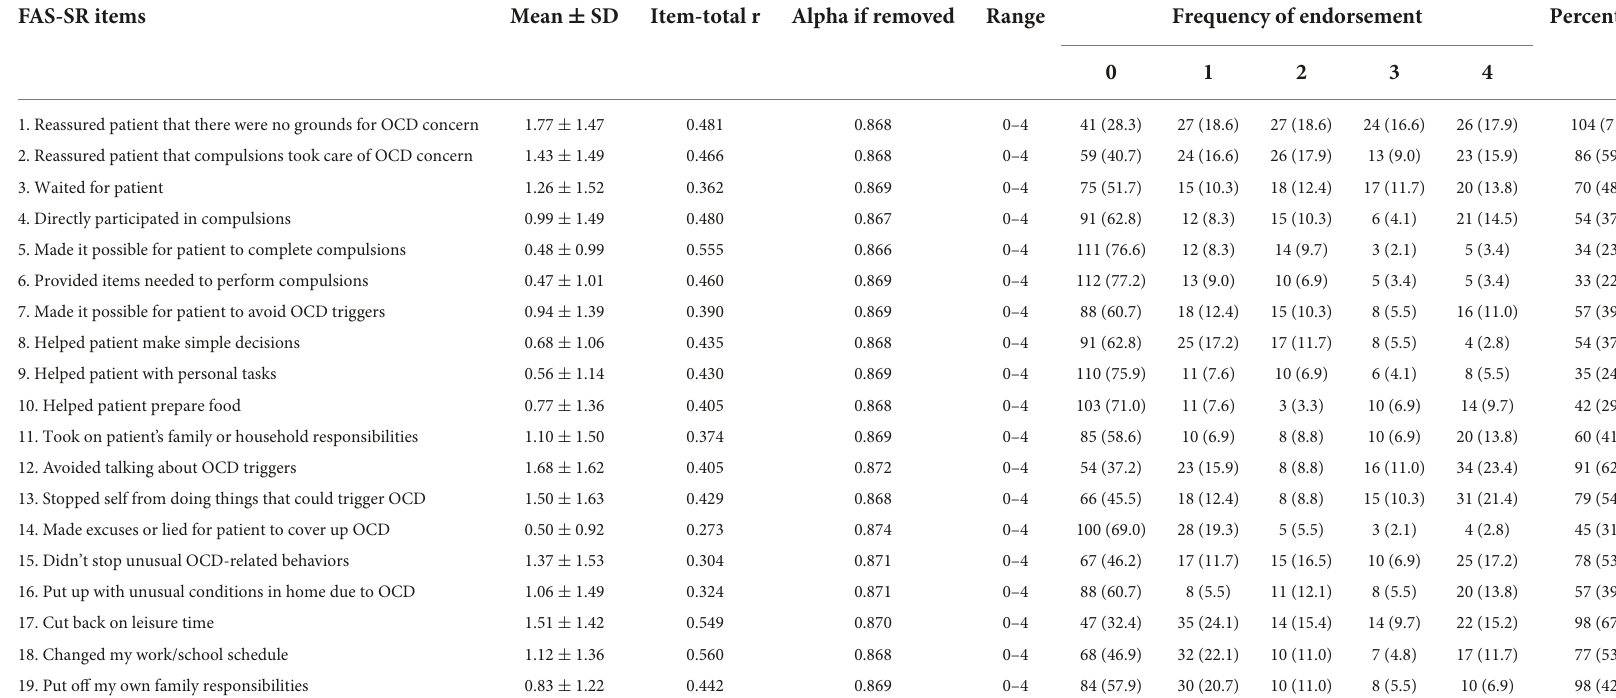
TABLE 3 The percentage of FAS-SR